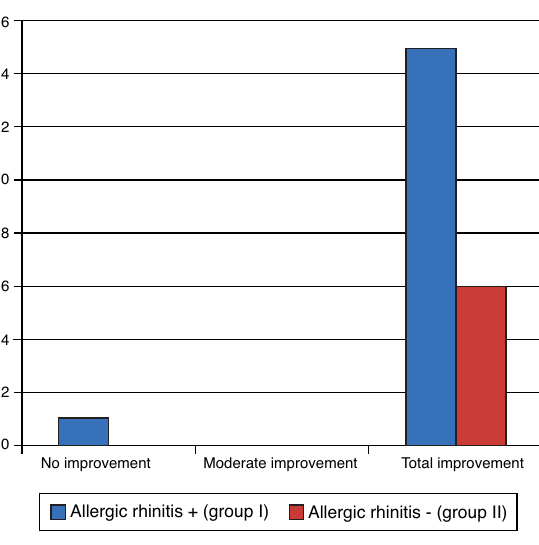
Figure 11 Degree of facial pressure improvement.